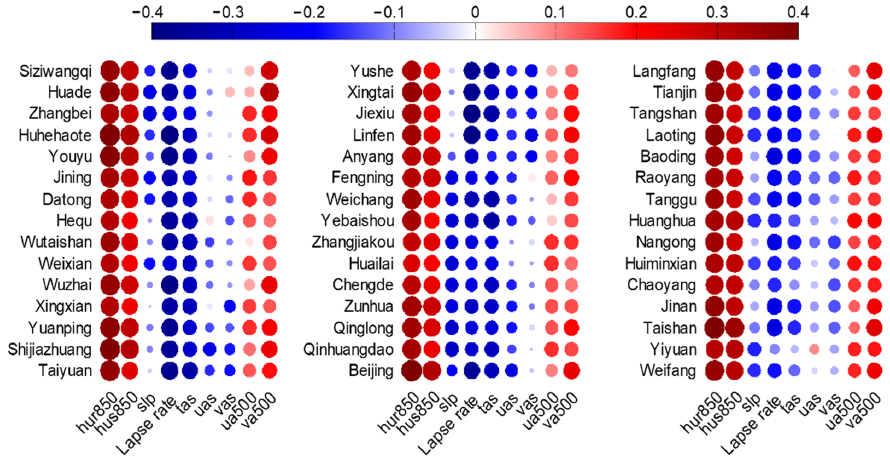
Figure 5. Calculation results of correlation coefficients between forecast factors and precipitation series at various stations in North China.